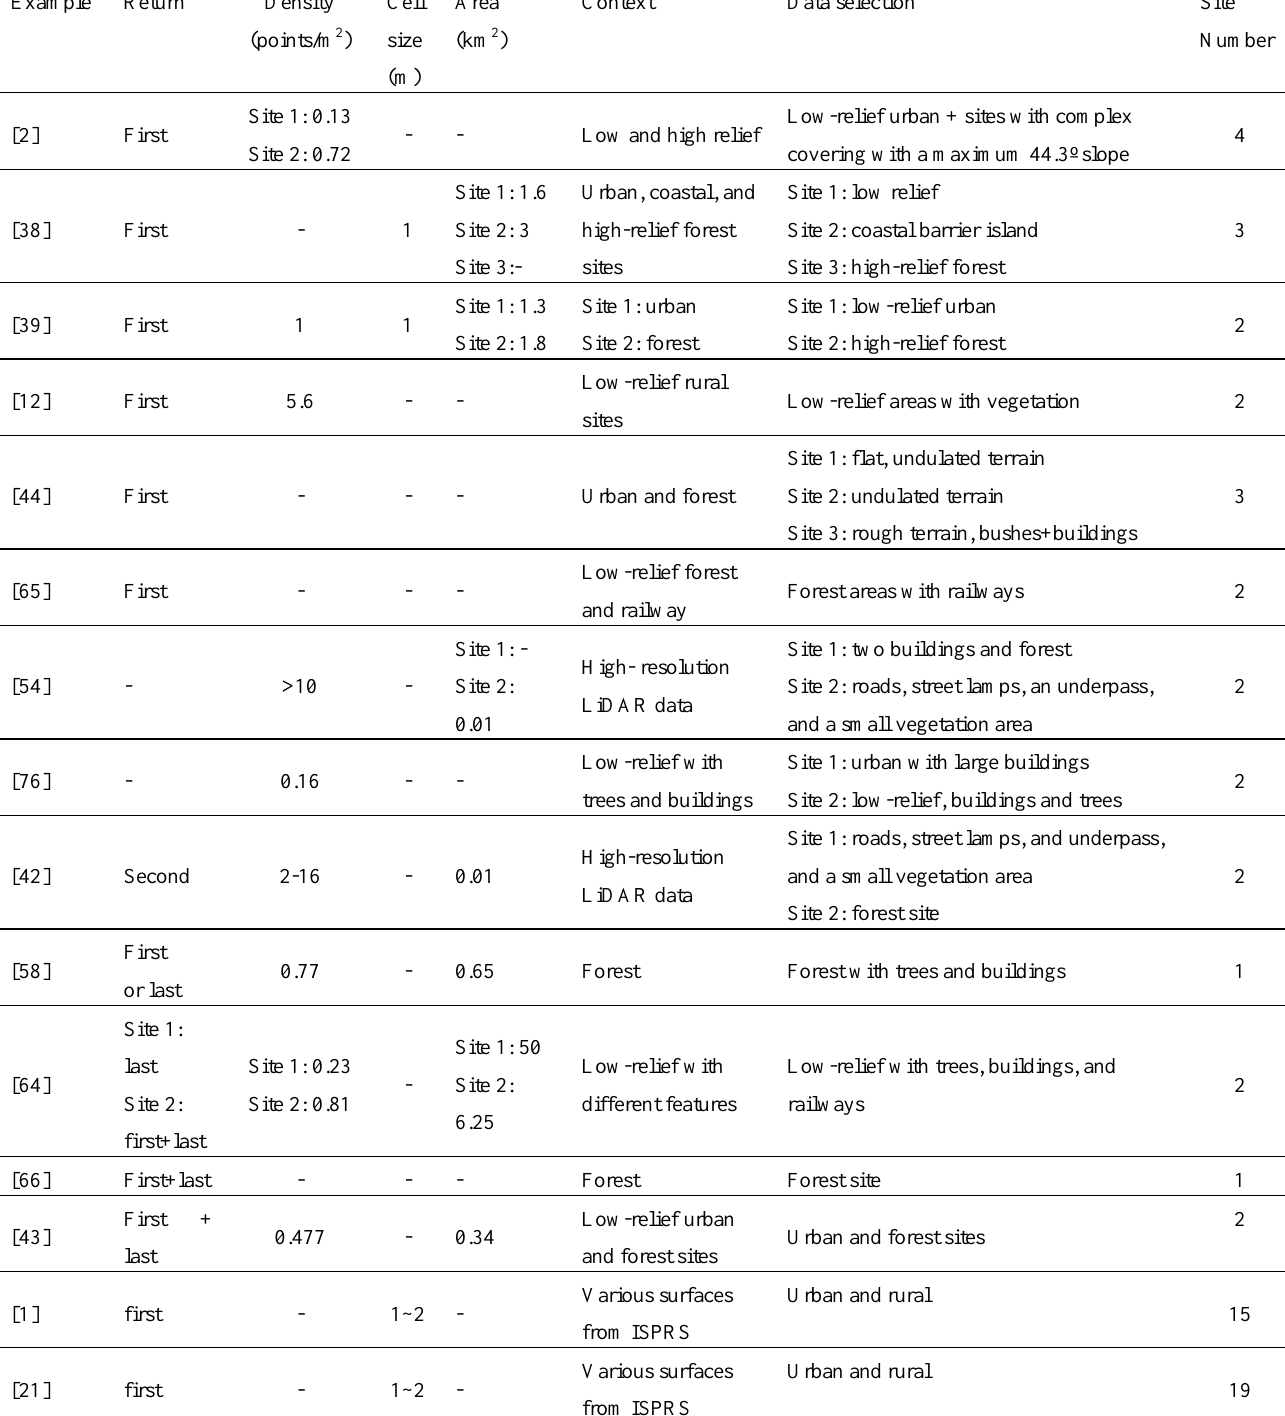
Table 1. Comparative table of the selection and description of study